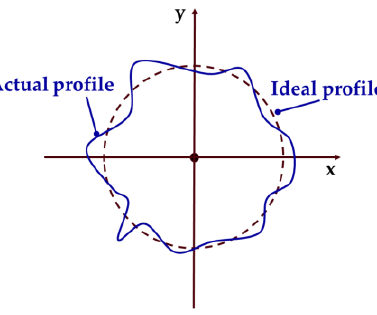
Figure 1. Schematic diagram of one cross-sectional profile.